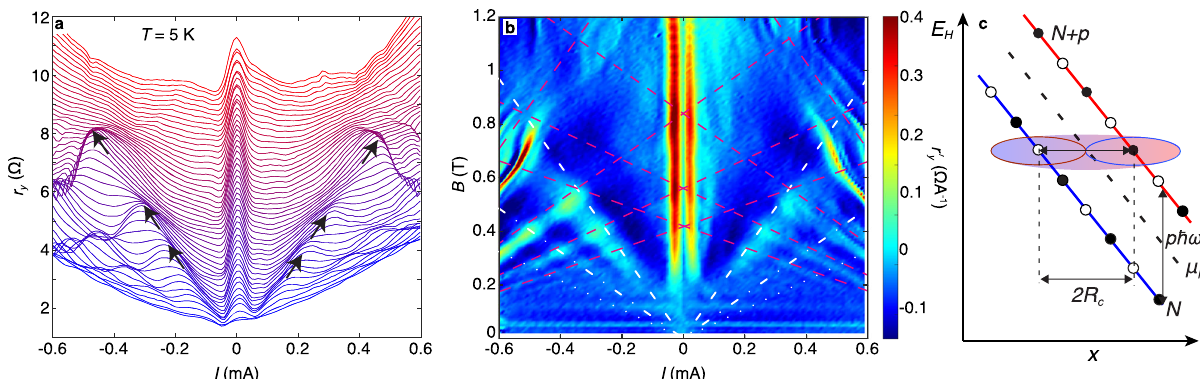
Fig. 3 Non-equilibrium magnetoresistance oscillations at T = 5 K: elastic inter-LL transitions. a Plot of r y ( I ) for values of B between 0 to 1.2 T in 0.04 T intervals when T = 5 K and n = 3.16 × 10 12 cm − 2 . Curves are offset by 1.5 Ω for clarity. Black arrows highlight position of peaks in r y . b Colourmap of r 0 y ð I ; B Þ when T = 5 K. Dashed white lines show the linear dependence of the B p on I , see Eq. (10), for the phononless resonances p = 1, 2, 3. In b , the magenta lines are a fi t given by Eq. (7) for the Hall- fi eld-dependent MPR peak with p = 1, 2, 3, 4. c shows how elastic inter-LL transitions can create a non-equilibrium distribution of carriers involving interacting electron – hole pairs, “ magneto-excitons ”